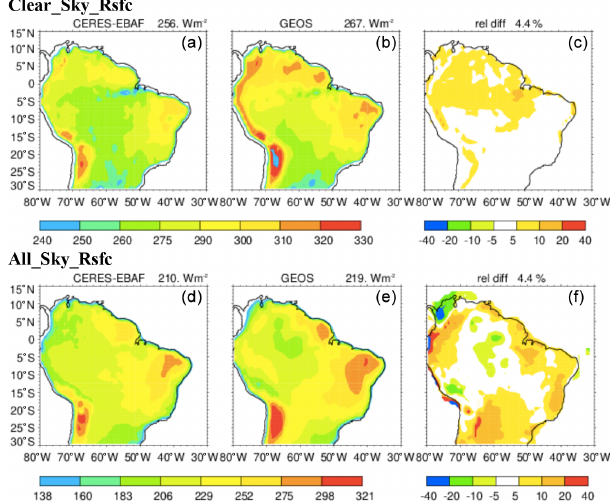
Figure 4. Comparison of surface downward shortwave radiation Rsfc (Wm − 2 ) between CERES-EBAF measurement and GEOS simulation averaged over August–October 2010–2016 for clear-sky ( a, b ) and all-sky ( d, e ) conditions. The right column (c, f) shows the relative difference between GEOS and